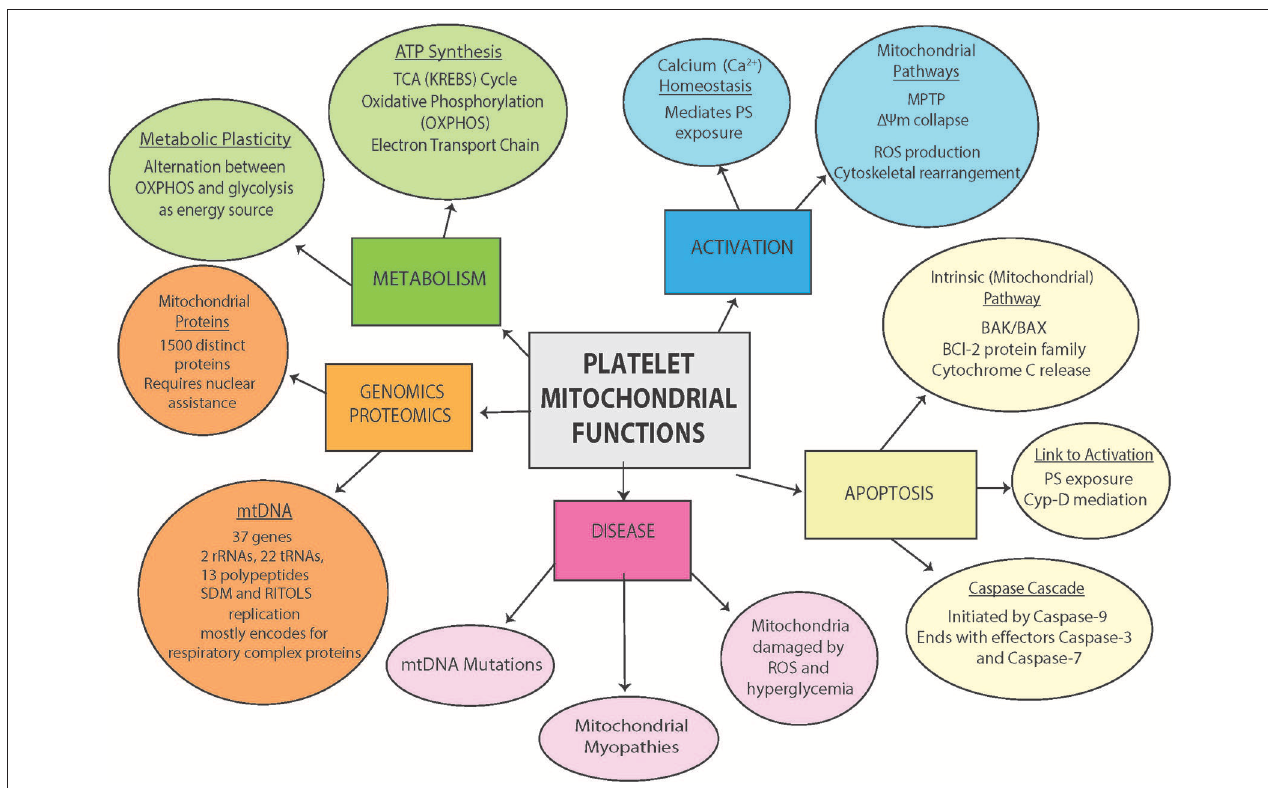
FIGURE 2 | Platelet mitochondrial Functions. Outlined are platelet mitochondria contents (genomics and proteomics), physiological function (metabolism), and involvement in pathology and disease (process of activation, apoptosis and disease